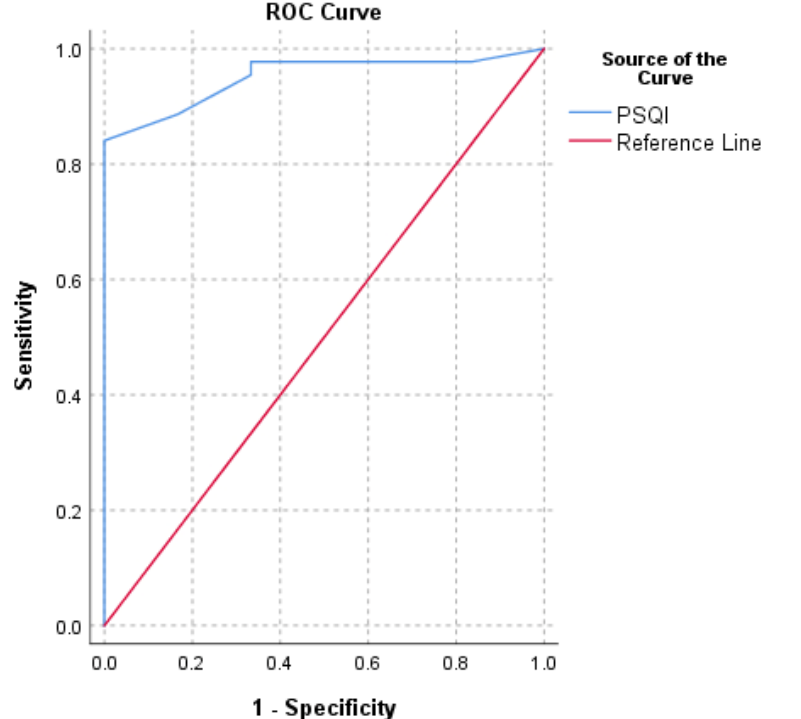
Table 2. Patient acceptable symptom state (PASS) for PSQI 1.